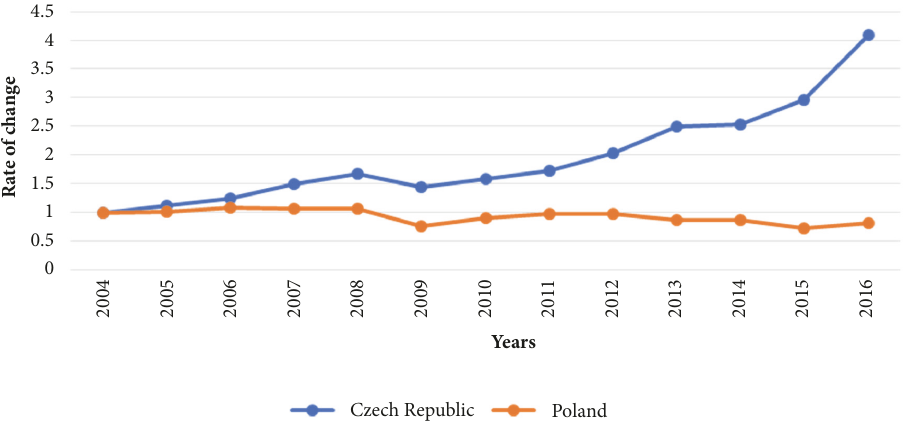
Figure 3: Rate of change of number of the railway passengers in the Czech Republic and Poland.